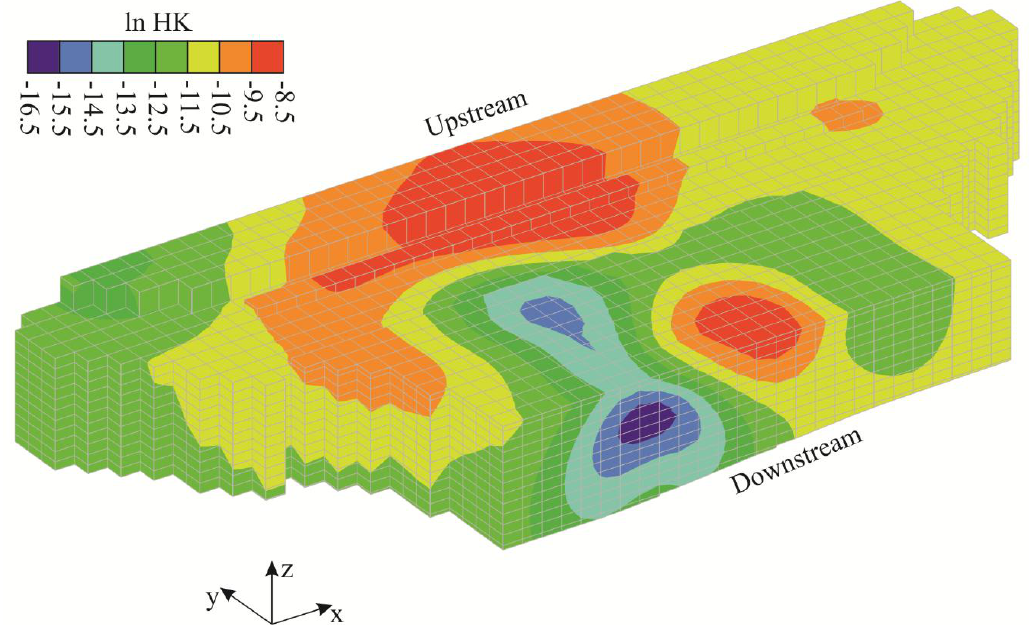
Figure 5. Three-dimensional view of the estimated hydraulic conductivity field: The results are reported in terms of natural logarithm of the parameters (ln HK) with units m/s in the physical space.